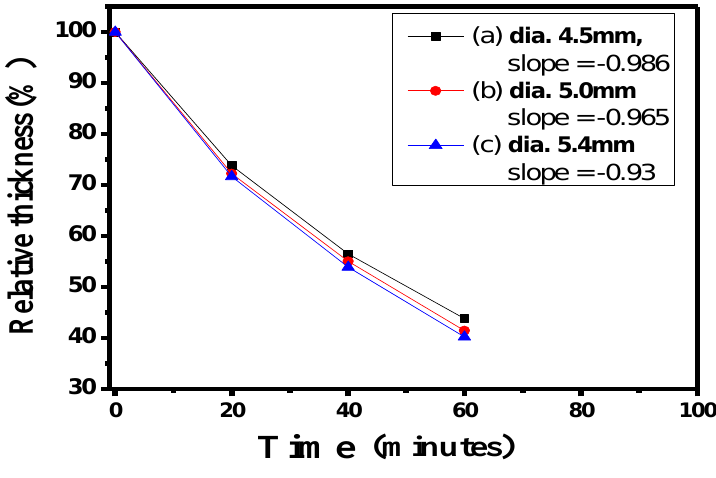
Figure 9. The curves of relative thickness versus time with SiO under the HF solution (1.0%), respectively (the formation of bulk SiO pH = 4, after standing for 3 days).